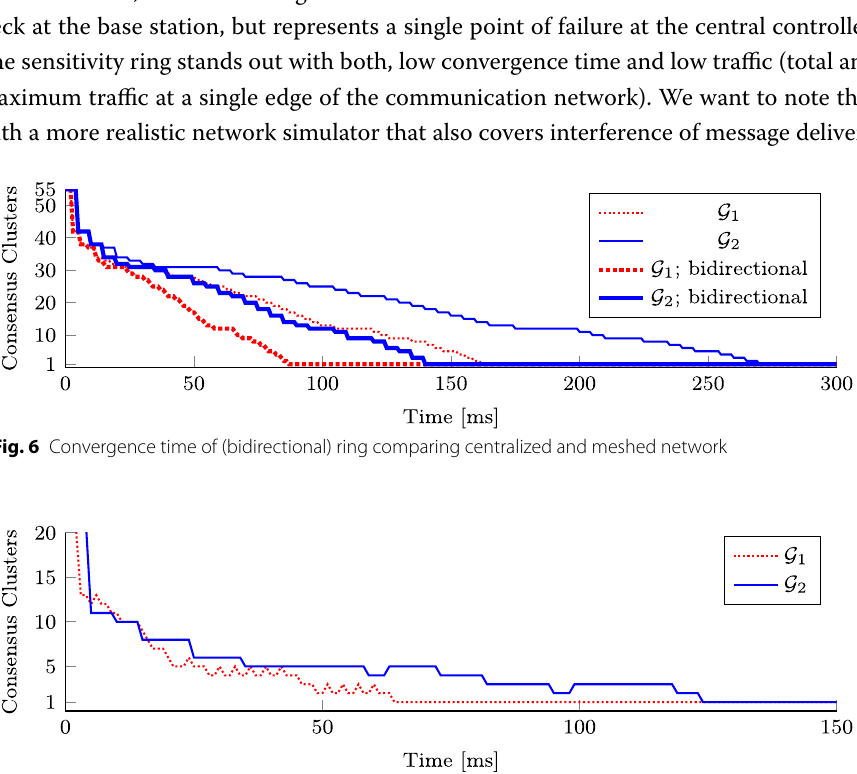
Fig. 7 Convergence time of sensitivity ring for regulated node 53. Note that only the 20 DRES agents need to agree on a